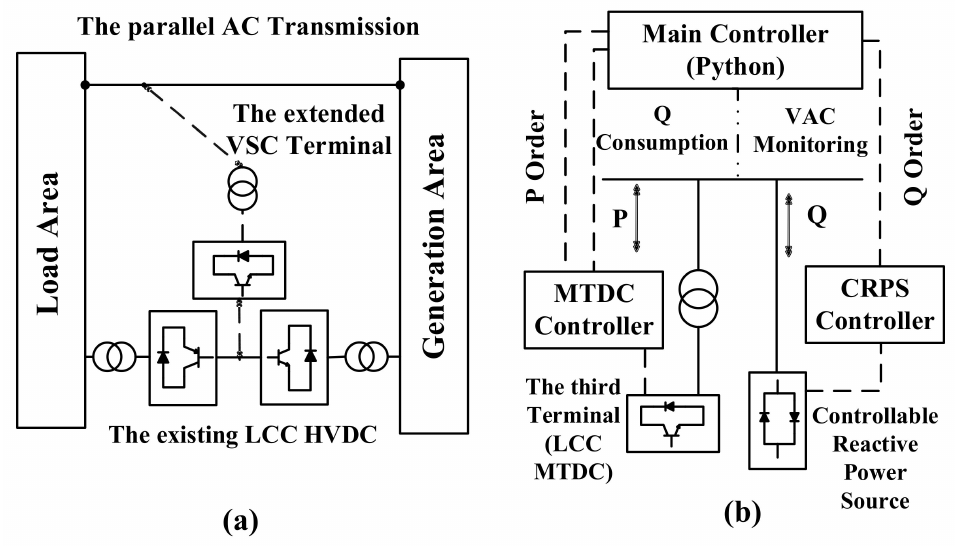
Figure 2. Extended MTDC architecture in power system. ( a ) Extended VSC terminal structure between generation and load. ( b ) Control architecture for MTDC system [15].